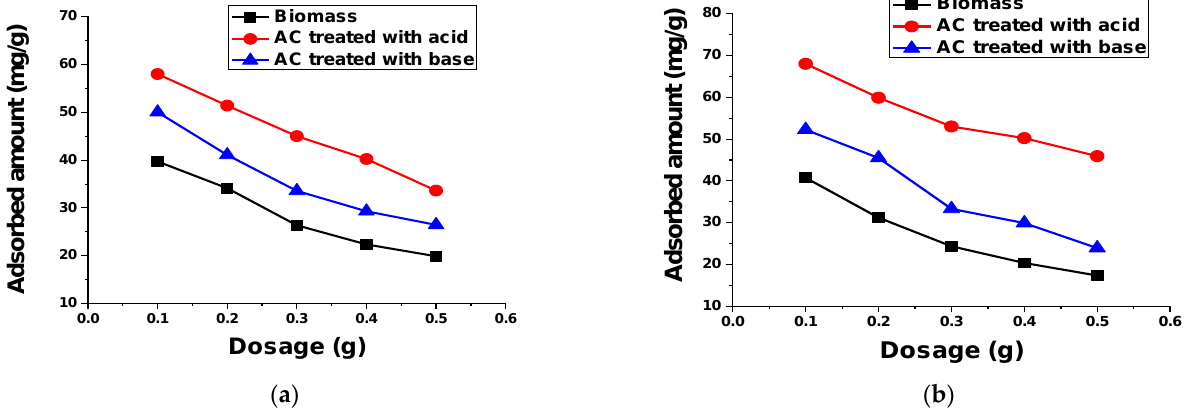
Figure 13. Effect of biomass and AC treated with acid and base amount on the adsorption of 50 mL ( a ) 100 mg/L TB and ( b ) 50 mg/L XO for 60 min at 140 rpm and room temperature.